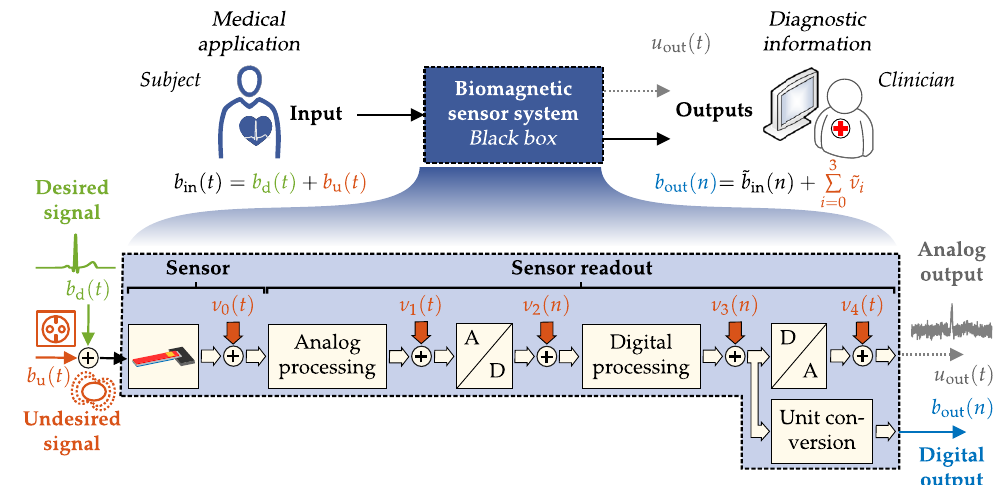
Figure 1. Schematic representation of a typical biomagnetic sensor